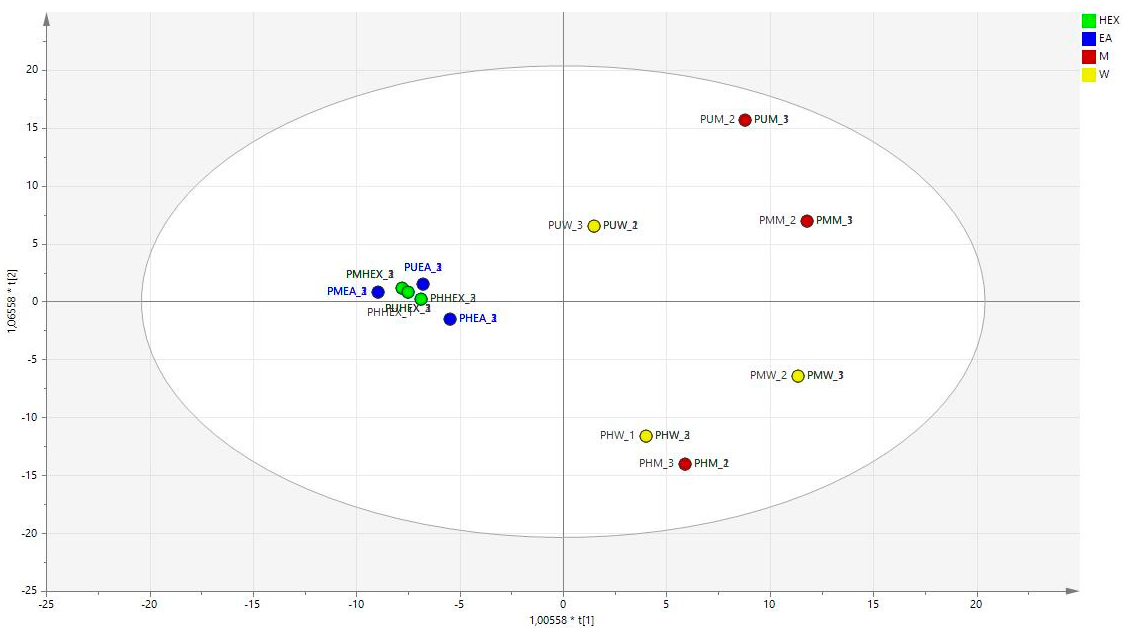
Figure 3. OPLS model considering all of the prepared extracts categorized on the basis of the solvents, HEX: hexane, EA: ethyl acetate, M: methanol, and W: water.